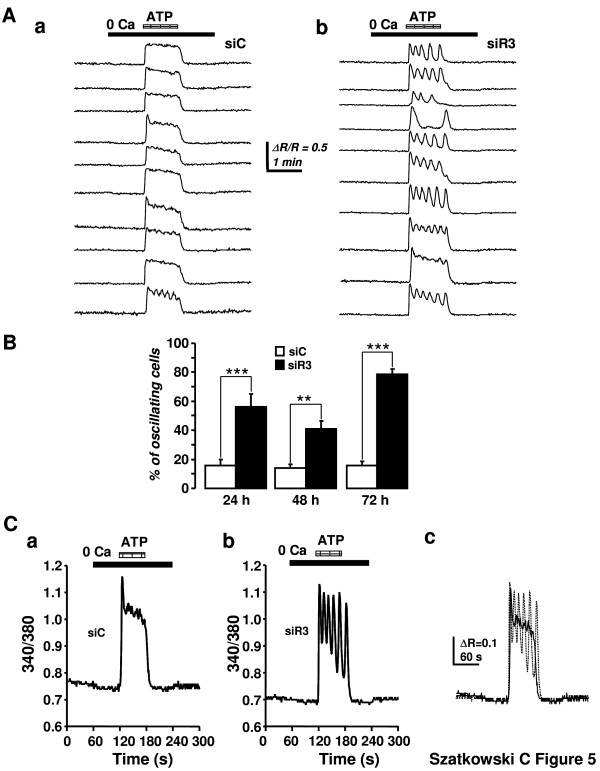
IP3R3 silencing changed the characteristics of ATP-induced Ca2+ signalling in MCF-7 cells. (A) Typical ATP-induced Ca2+ signals in MCF-7 cells 72 h after their transfection with siC (a) or siR3 (b). ATP (5 μM) was perfused in a Ca2+-free recording solution in order to avoid Ca2+ entry. The Ca2+ response changed from a plateau-type pattern to a characteristic oscillatory pattern in siR3-transfected cells. Representative for 6 independent experiments. (B) Statistical analysis of the effect of IP3R3 silencing at 24, 48 and 72 h post-transfection on the percentage of oscillating cells in response to 5 μM ATP in a Ca2+-free recording solution. IP3R3 gene silencing resulted, at any time, in a strong augmentation of the percentage of cells that respond to ATP by an oscillatory Ca2+ signal. (C) Typical ATP-induced Ca2+ signals recorded in a Ca2+-free medium 72 h after transfection with siC (a) or siR3 (b). Ca2+ signals presented in a (full line) and b (dotted line) were superimposed in order to clearly show the modification of the pattern of the Ca2+ response (c).